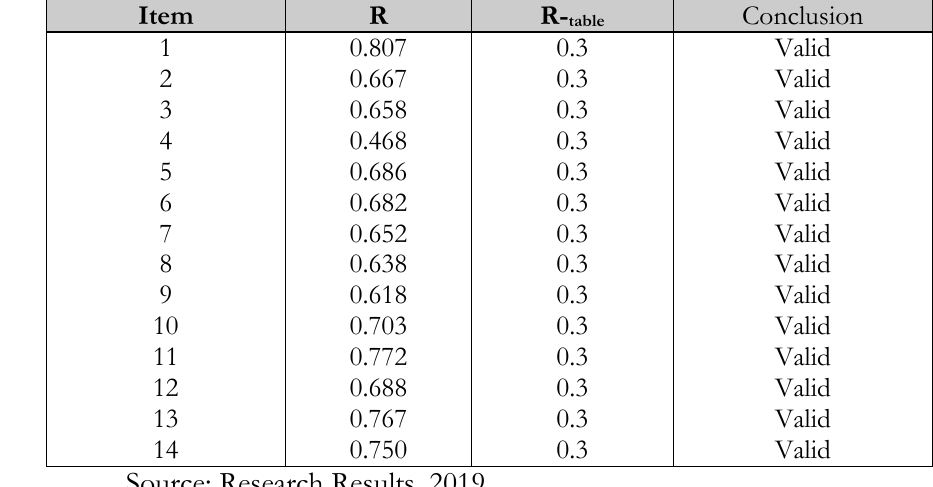
Test Results Validity of Application of Accounting Information